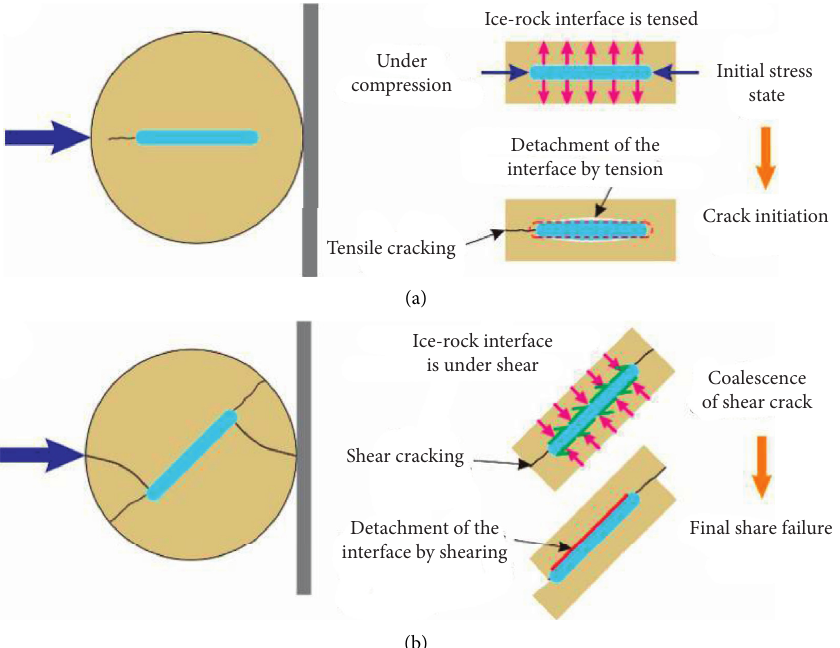
Figure 8: Schematic diagram of the mechanism of how ice alters the dynamic properties of frozen fractured